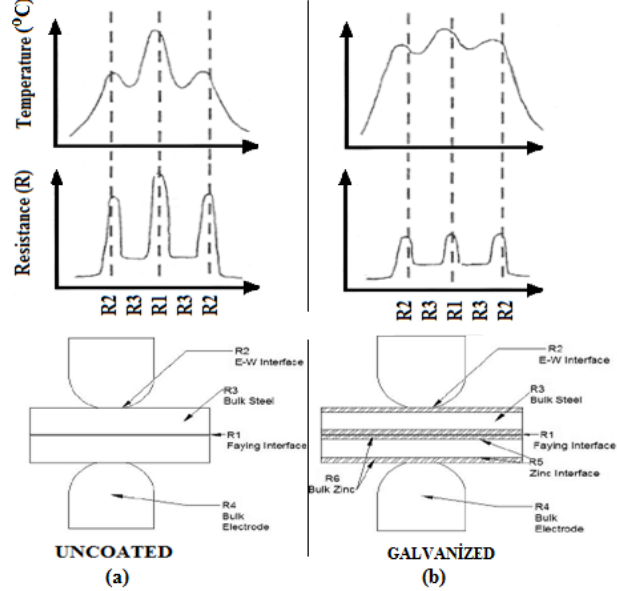
Figure 1. The resistance and resultant temperature profile for ( a ) uncoated; ( b ) galvanize-coated samples [15,16].